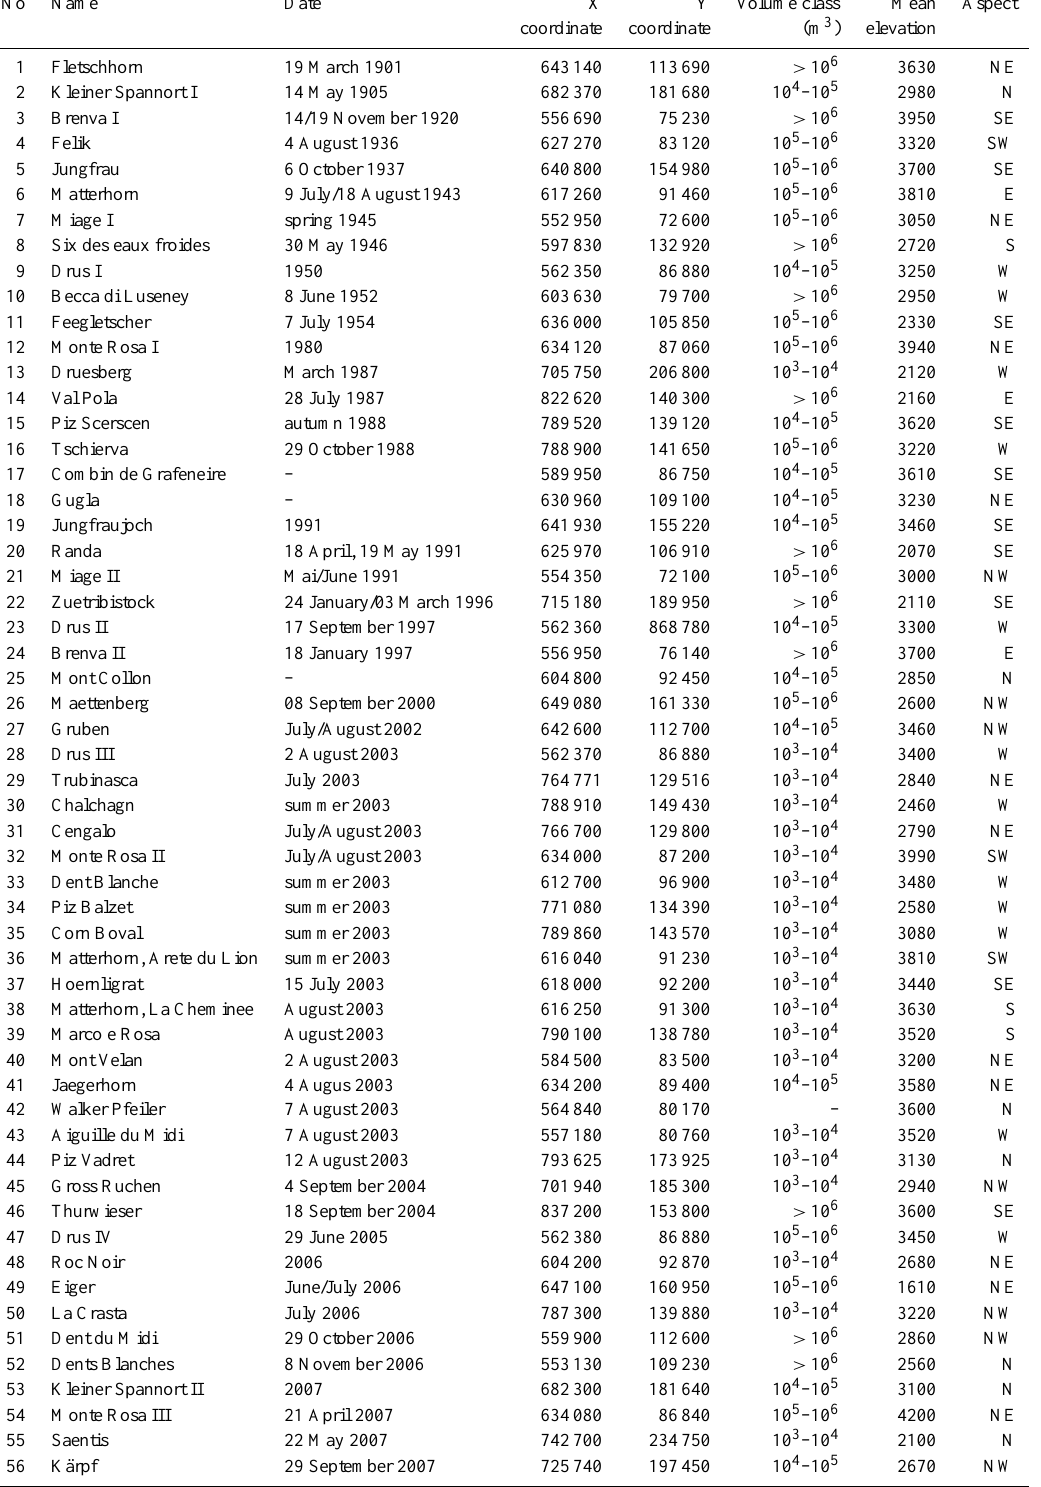
Table 1. Characteristics of the 56 sites with recorded rock avalanche and rockfall